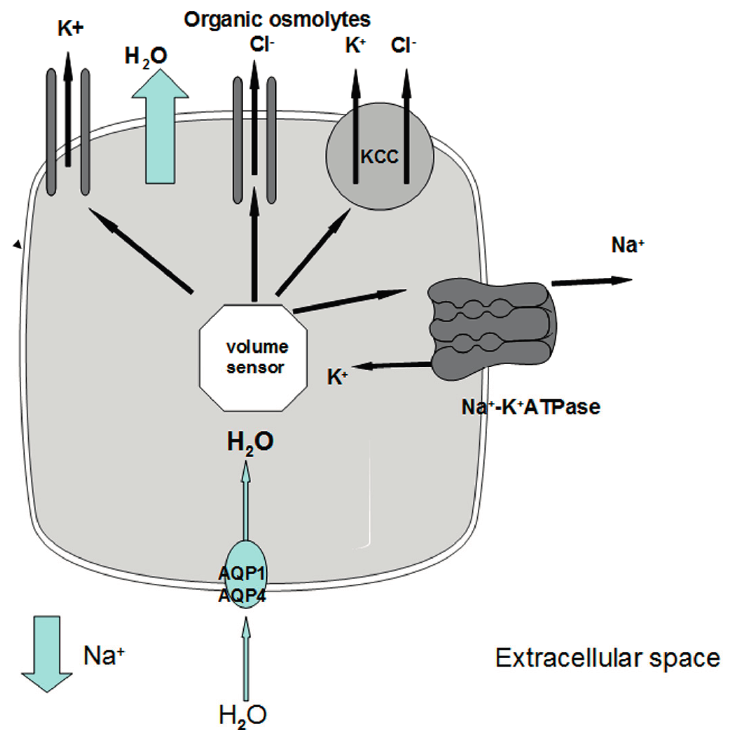
Figure 2. Schematic representation of cellular responses leading to swelling in chronic hyponatremia. When extracellular [Na + ] decreases, water entry into the cells through AQP1 and AQP4 causes an increase in cell volume that triggers a volume sensor. Activation of the volume sensor causes an efflux of electrolytes through the Na + -K + ATPase, the K + channels, the KCC transporter and a volume sensitive Cl − channel that also mediates the extrusion of Cl − and organic osmolytes. AQP1: type 1 aquaporin water channel; AQP4: type 4 aquaporin water channel; KCC: K + -Cl − cotransporter.